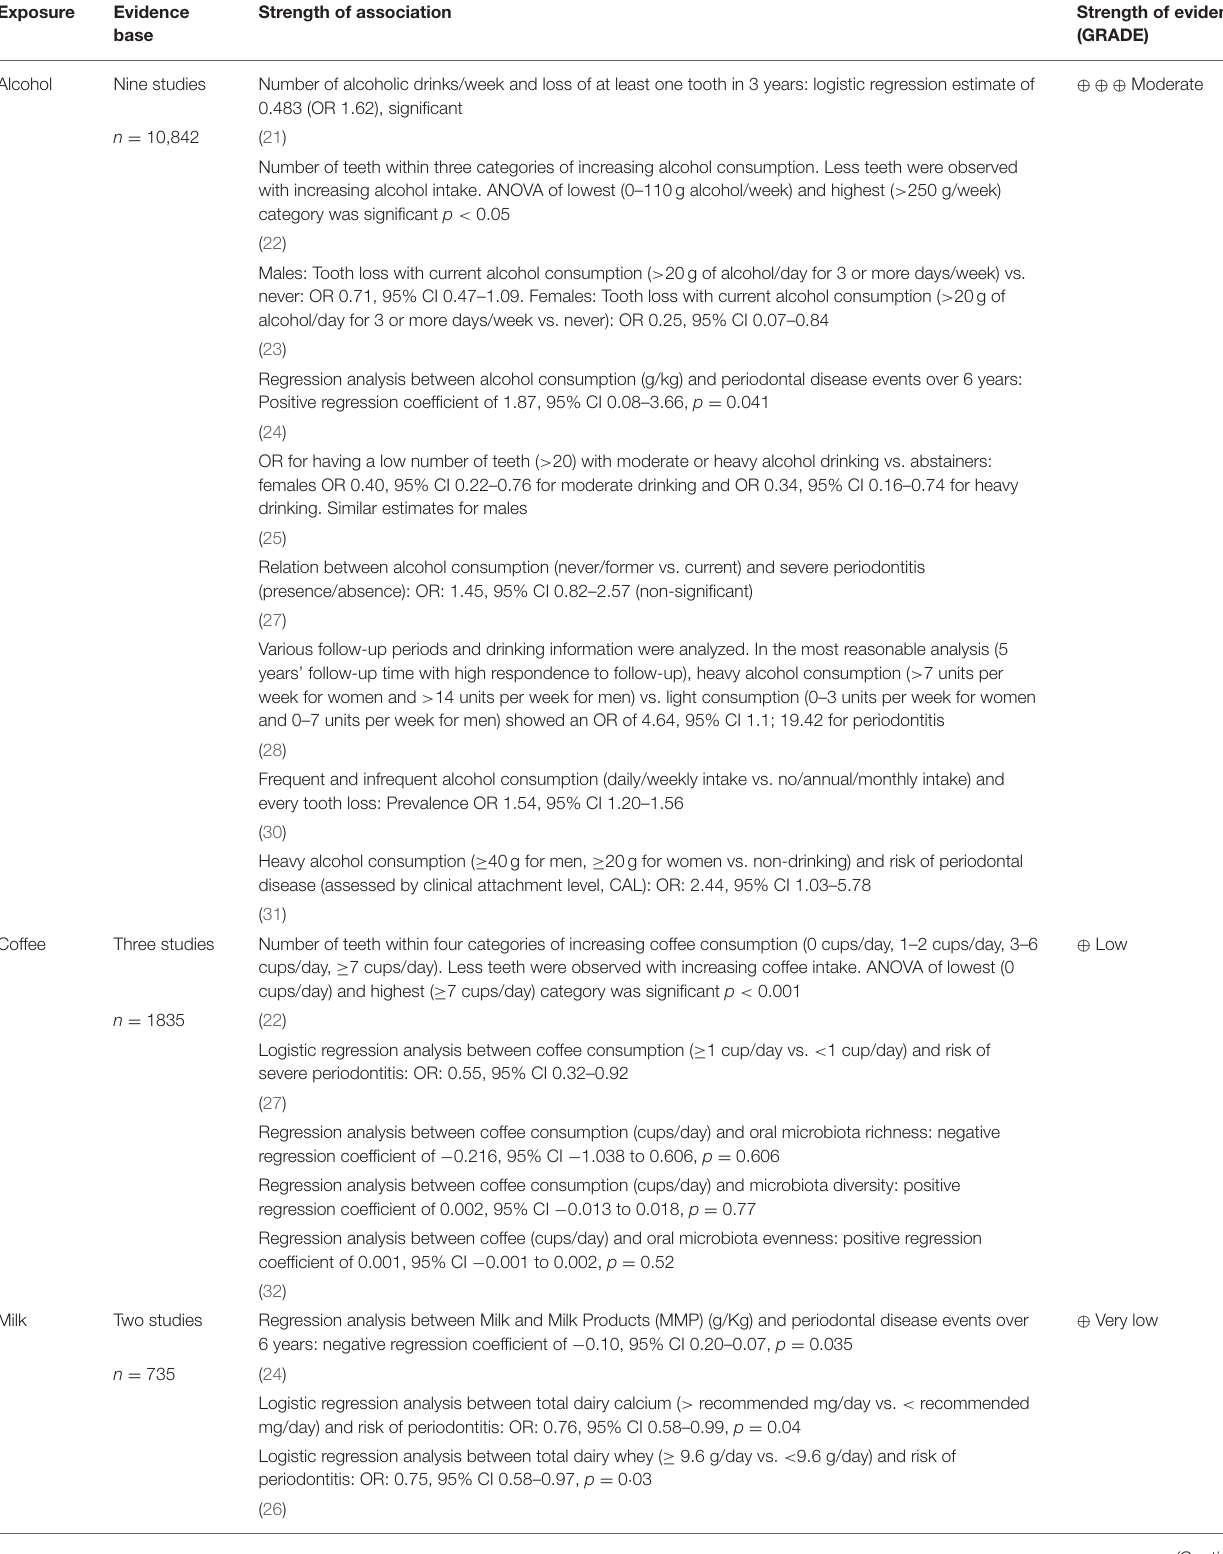
TABLE 2 | Summary of findings about different beverages associated to oral health items in older age. Exposure Evidence Strength of base